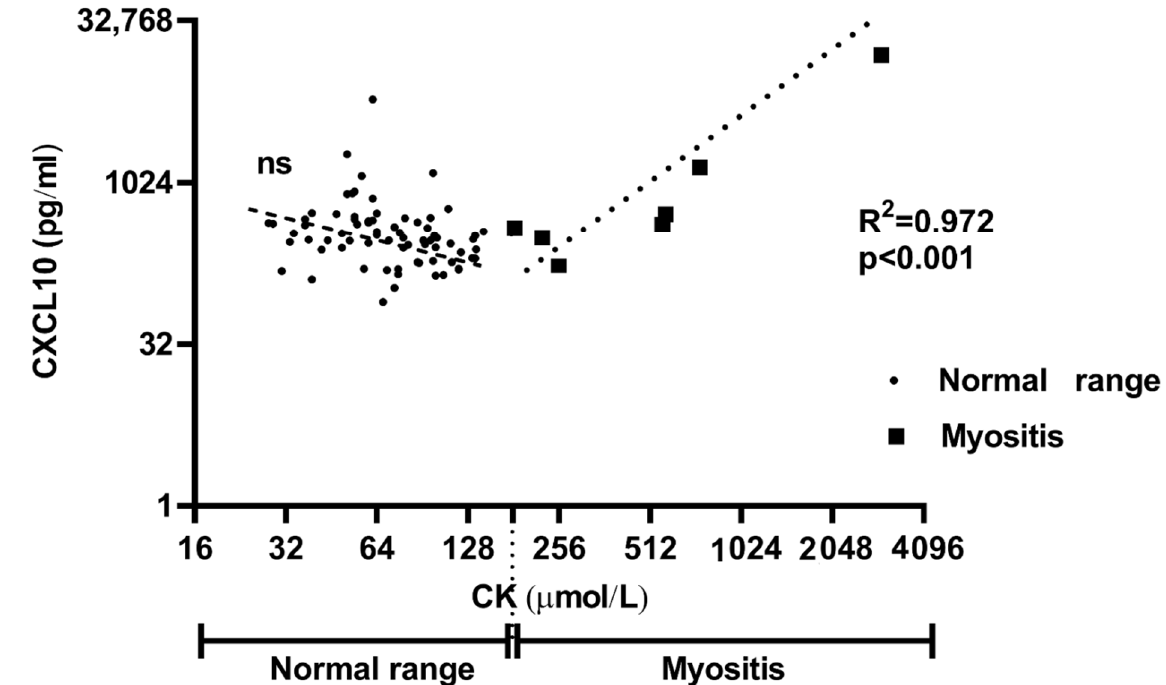
Figure 2. CXCL10 serum level positively correlates with an above normal range of creatine kinase (CK) blood level in SSc patients. The scatterplot has the CK blood level in µ mol/L on the horizontal (X) axis, and the CXCL10 serum level, in pg/mL, on the vertical (Y) axis. CK < 180 µ mol/L is considered the cut-off of normal range. Each individual is identified by a single point (dot) on 180 mol/L; each square symbolizes SSc–myositis patient with CK > 180 µ mol/L (above normal range). SSc patients with a CK > 180 µ mol/L showed higher levels of circulating CXCL10. The relationship between CK blood level and serum CXCL10 levels in SSc–myositis patients is strong, linear, and positive with a Pearson’s correlation coefficient of +0.97 ( p < 0.001). No significant correlation is observed in SSc patients with CK within normal range ( R 2 = 0.02, p = 0.245).